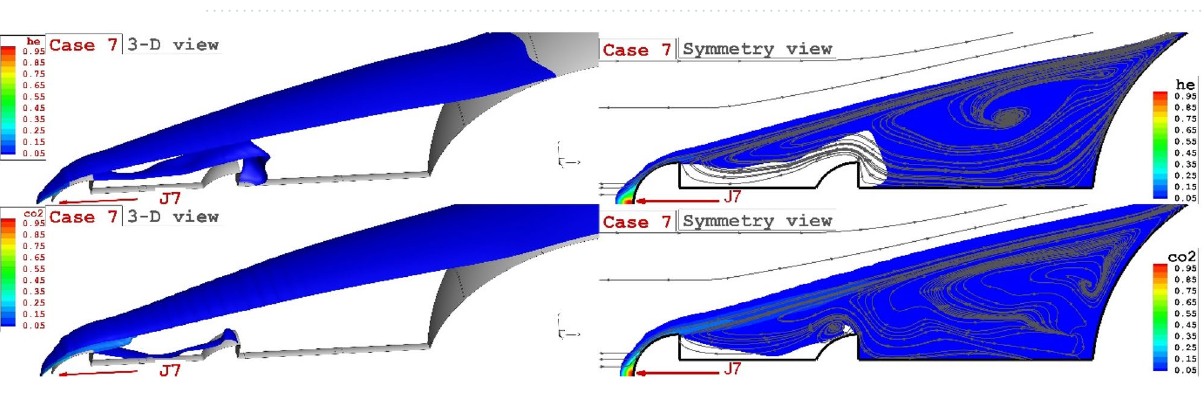
Figure 8. Comparison of the